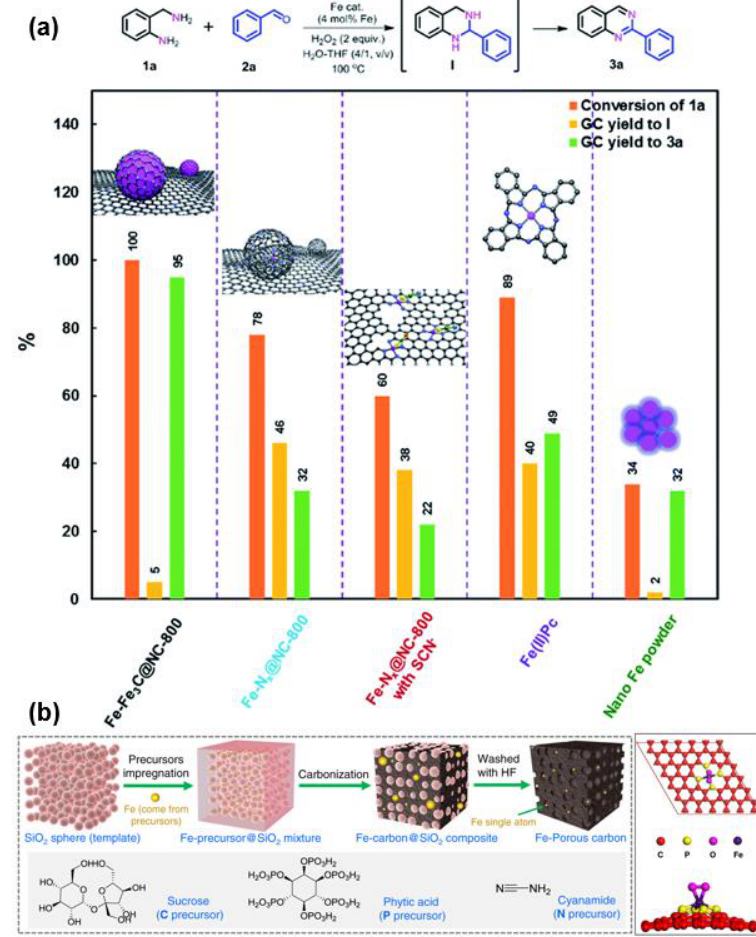
Figure 5. ( a ) The control experiments on the synergistic catalysis between FeN x sites and Fe NPs. Reprinted with permission from Ref. [58]. Copyright 2019, Royal Society of Chemistry. ( b ) The synthetic route of Fe-P-C. Reprinted with permission from Ref. [64]. Copyright 2020, Springer Nature.